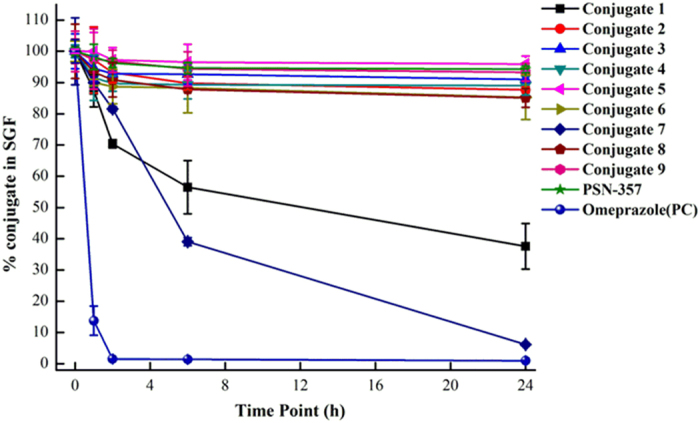
Time-course of SGF stability for conjugates 1–9 (n = 3).